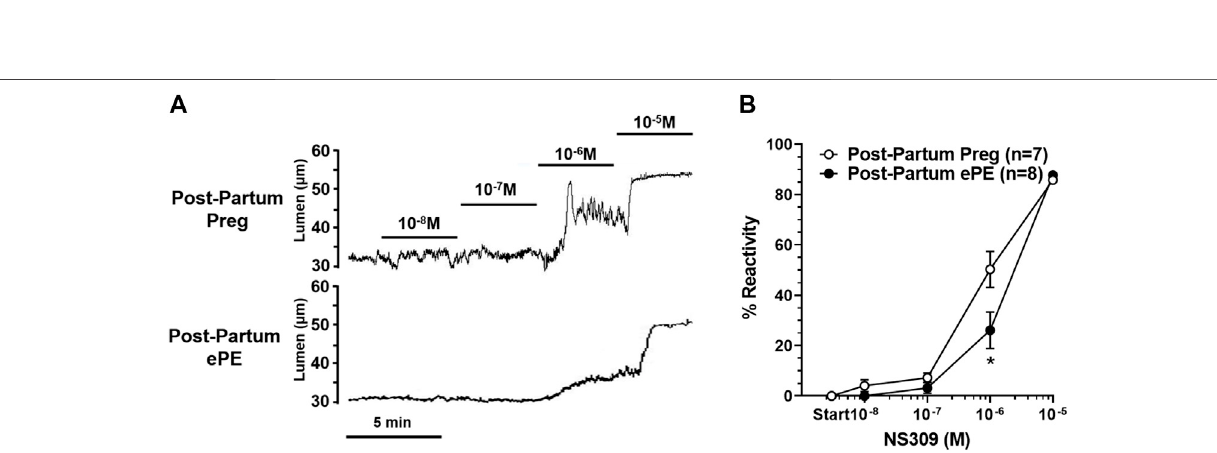
FIGURE 3 | Reactivity of hippocampal arterioles (HAs) to small- and intermediate-conductance calcium-activated (SK Ca /IK Ca ) channel activation. (A) Representative lumen diameter tracings of HAs from one Post-Partum Preg and one Post-Partum ePE rat during the concentration response curve to the SK Ca /IK Ca channel agonist NS309. Solid lines represent cumulative doses of NS309 from 10 − 8 M to 10 − 5 M. (B) Percent reactivity of HAs in response to increased concentrations of NS309 was shifted to the right in arterioles from Post-Partum ePE rats compared to those from Post-Partum Preg rats. Data are mean ± SEM, * p < 0.05 by Mann-Whitney